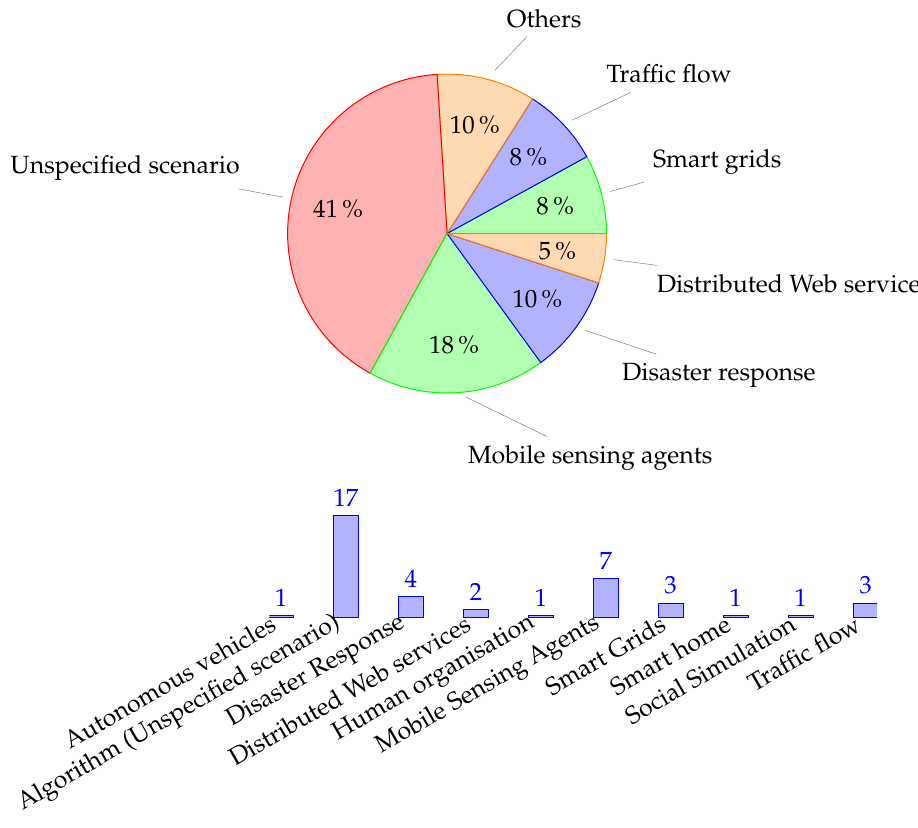
Figure 6. Distribution and summary of topics and scenarios